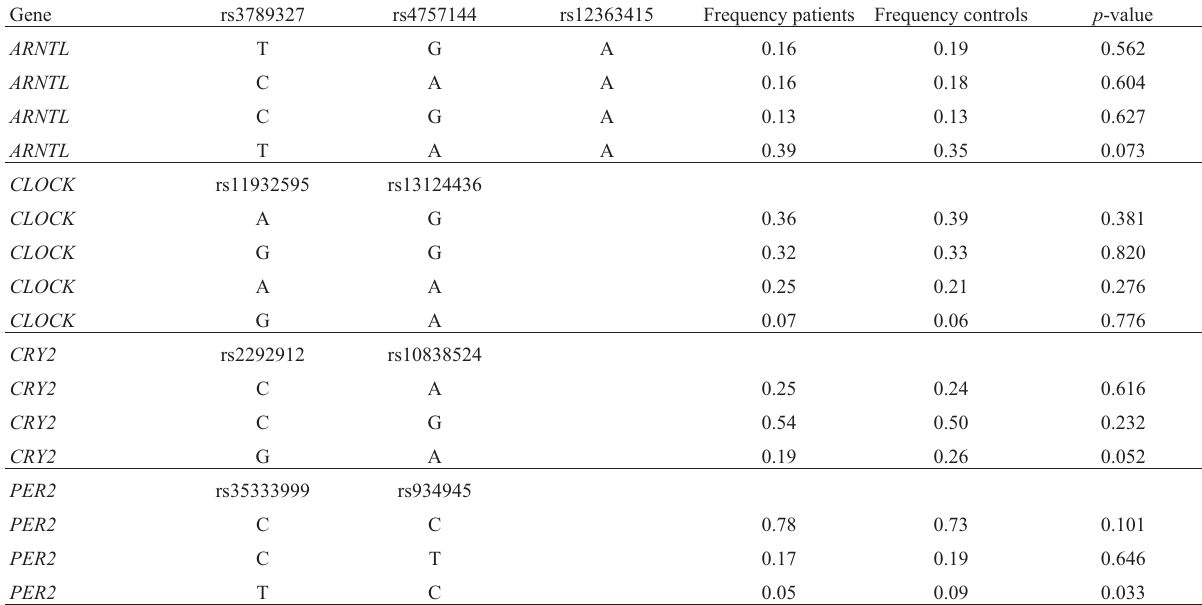
Table 4 - Frequencies and distribution of probable haplotypes in the patients and the control